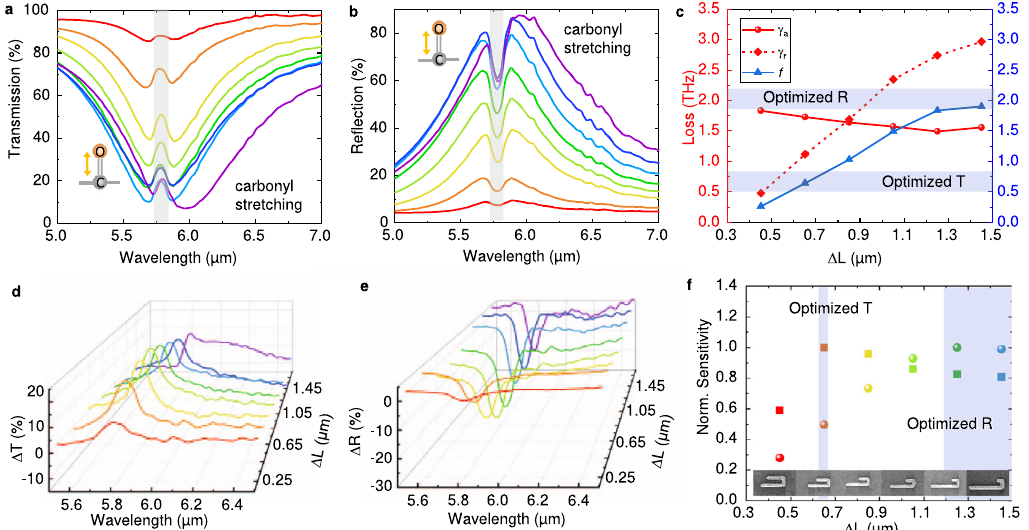
Fig. 3 Experiment characterization of hook nanoantennas sensing performance. a, b The testing transmission ( a ) and re fl ection ( b ) spectra of hook nanoantenna devices with different Δ L for PMMA thin fi lm sensing. The carbonyl stretching vibration in 5.76 μ m or 1736 cm − 1 is used to characterize the sensitivity of hook nanoantennas. The colors of the line refer to the different Δ L in e, f . c The extracted absorptive and radiative loss of hook nanoantennas by fi tting the experimental spectra with TCMT. d, e The baselined corrected spectra difference in transmission( d ) and re fl ection( e ). f The calculated sensitivity of hook nanoantenna devices with different Δ L. The sphere symbols refer to re fl ection mode and square symbols represent transmission